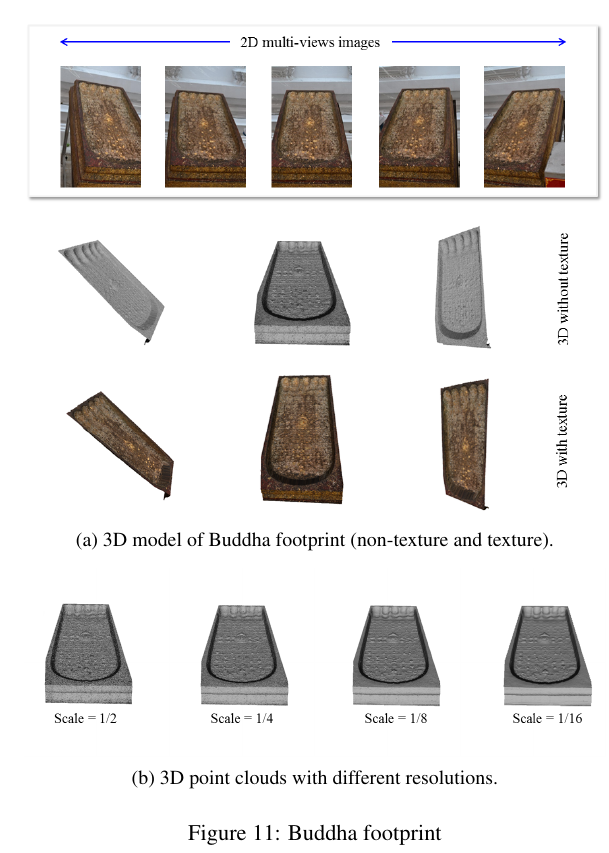
(a) 3D model of Buddha footprint (non-texture and texture).